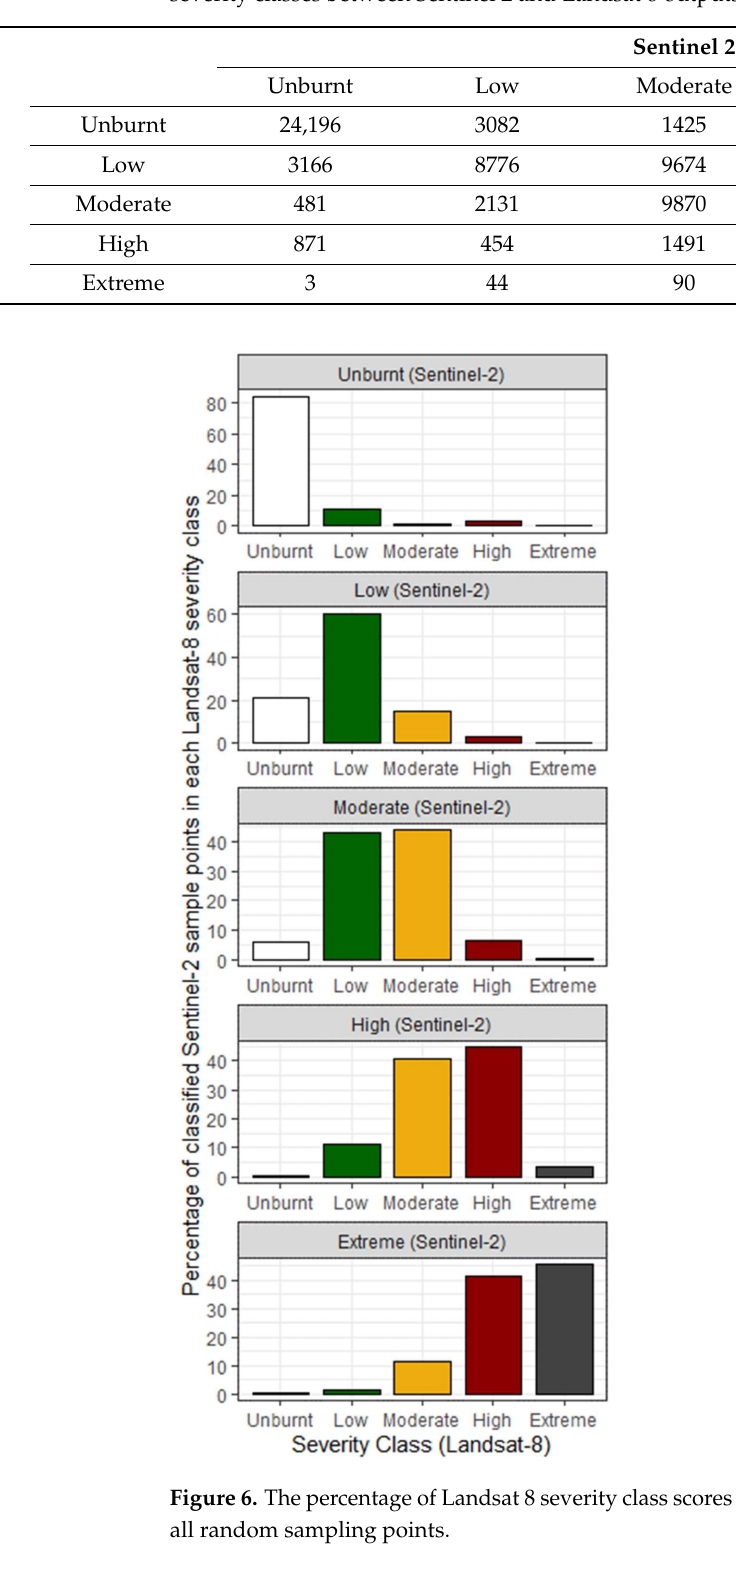
Table 6. Confusion matrix for 111,994 random sampling points across all 27 case study fires comparing severity classes between Sentinel 2 and Landsat 8 outputs.